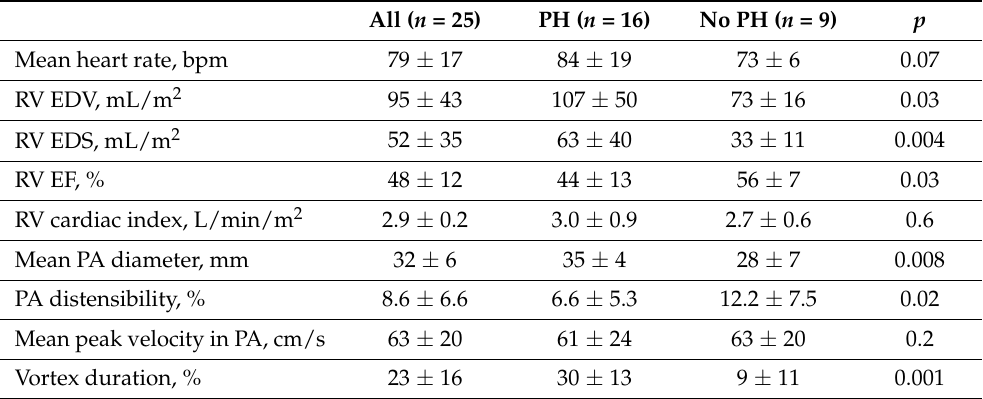
Table 3. Cardiac MRI parameters in the overall population and between patients with and without pulmonary hypertension on RHC (defined as a mean pulmonary pressure ≥ 25